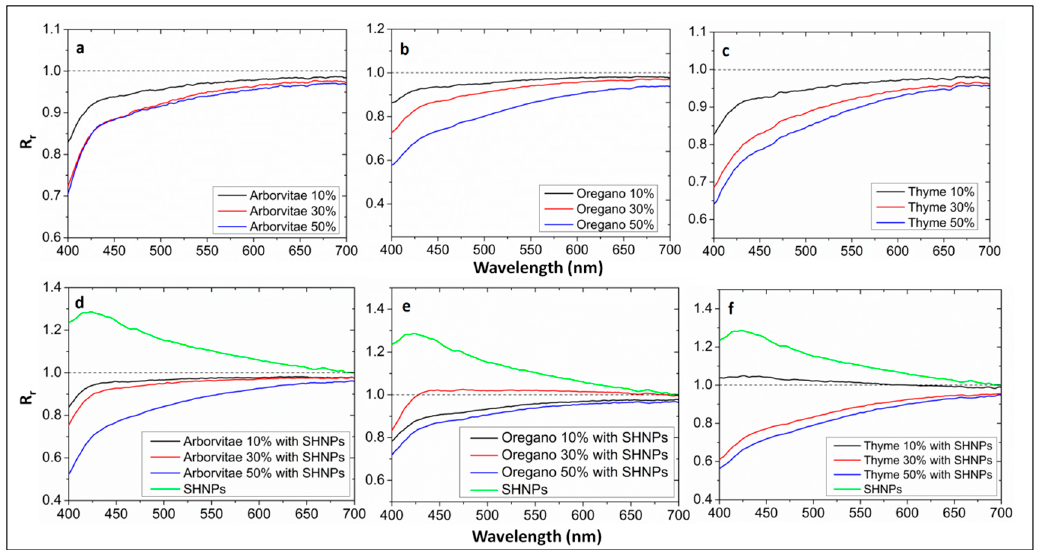
Figure 1. Dependence of the reflectivity ratio Rr as a function of wavelength for whitewood samples.